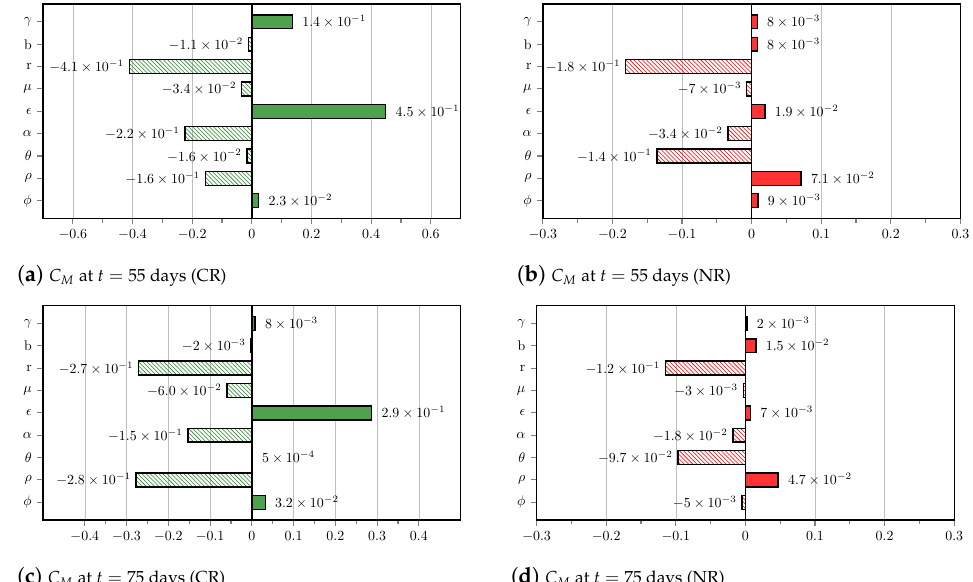
Figure 7. Tornado plots of the Pearson correlation with respect to C M at t = 55 days (top panel) and t = 75 days (bottom panel). VP was split into two groups according to the therapy outcomes at 300 days: CR (green) and NR (red). Solid bars indicate a positive effect, while dashed bars indicate a negative one. It is worth noting the important role of the parameter related to memory conversion ( (cid:101) ), which counteracts the intense negative effect of r for CR cases. For NR cases, the negative effect of both r and θ prevented therapy success. The correlation values at t = 75 days are slightly smaller than those at t = 55 days, and one may notice a change of order in the rank of the most influential parameters for CR